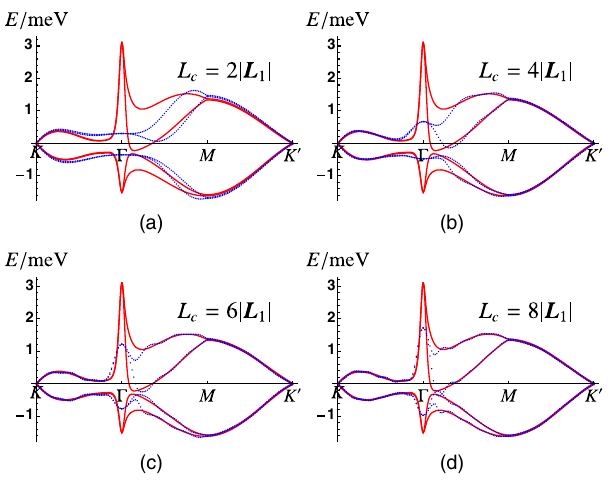
FIG. 4. Comparison of the narrow-band structure produced by the model given by Ref. [20] (red solid line) and the tight-binding model based on the WSs (blue dots) with the range of